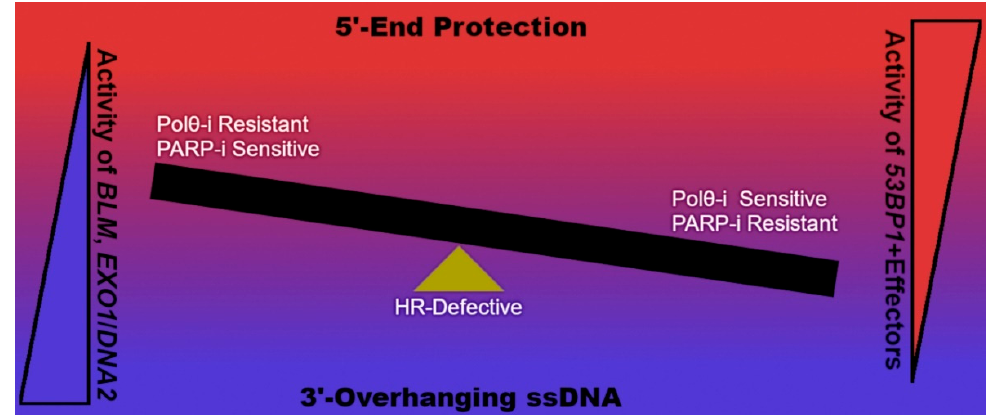
Figure 5. High sensitivity to Pol θ -i in HR-defective cells depends on enzymatic generation of extensive 3 ′ -overhanging ssDNA by processive exonucleases. Inhibitors of pol θ may obstruct acquired resistance to PARP-i in cancer patients with BRCA -gene mutations by thwarting down-regulation of 53BP1 or its effector complexes known to inhibit 5 ′ -end resection.